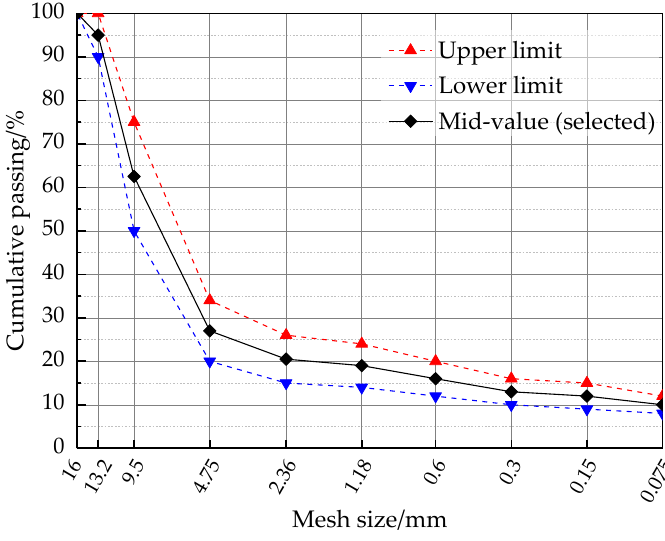
Figure 1. Gradation of SMA-13 in this study.